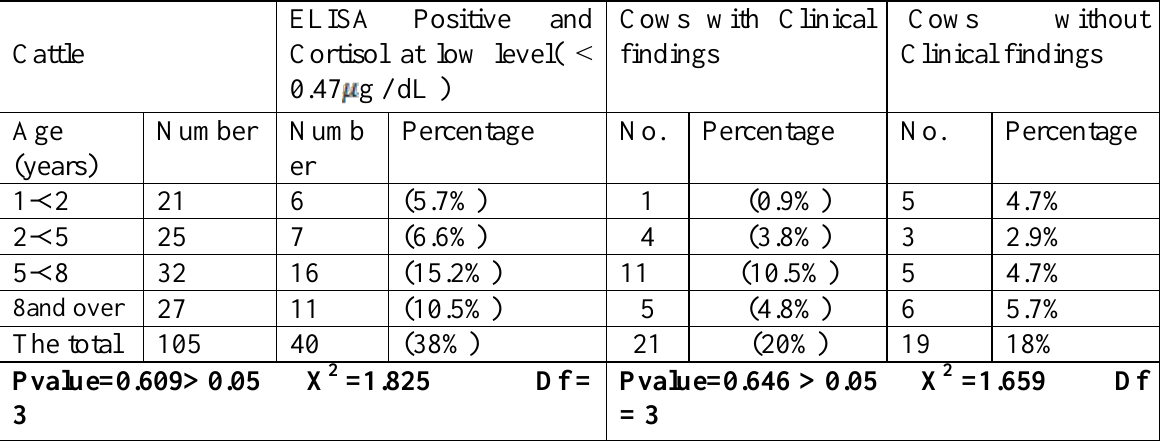
Table (3): first group ELISA positive and cortisol at low level, and 21 cattle with a clinical findings of heat